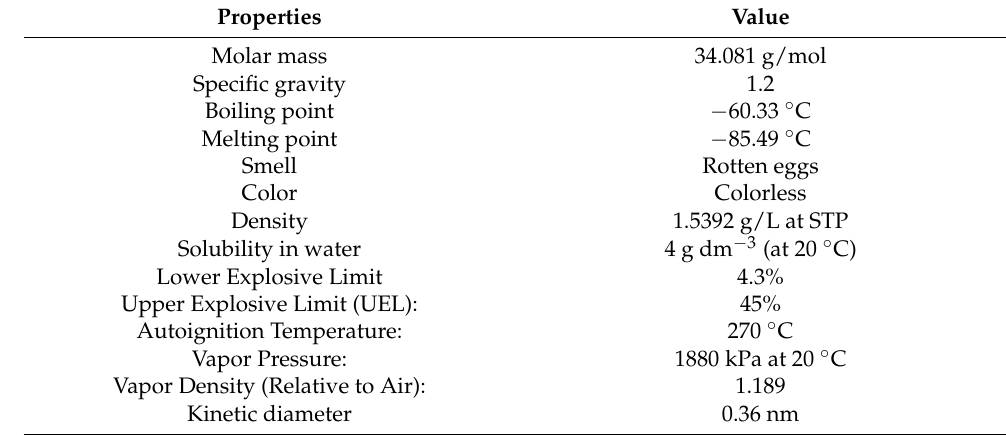
Table 1. Chemical and physical properties of H 2 S